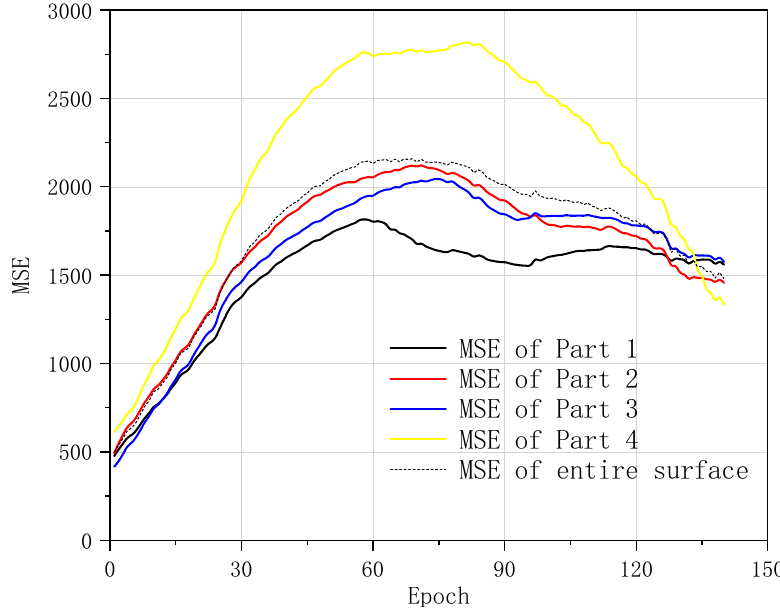
Figure 5. Mean square error (MSE) values between standard FEA and the terrestrial laser scanning (TLS)-based reference result.